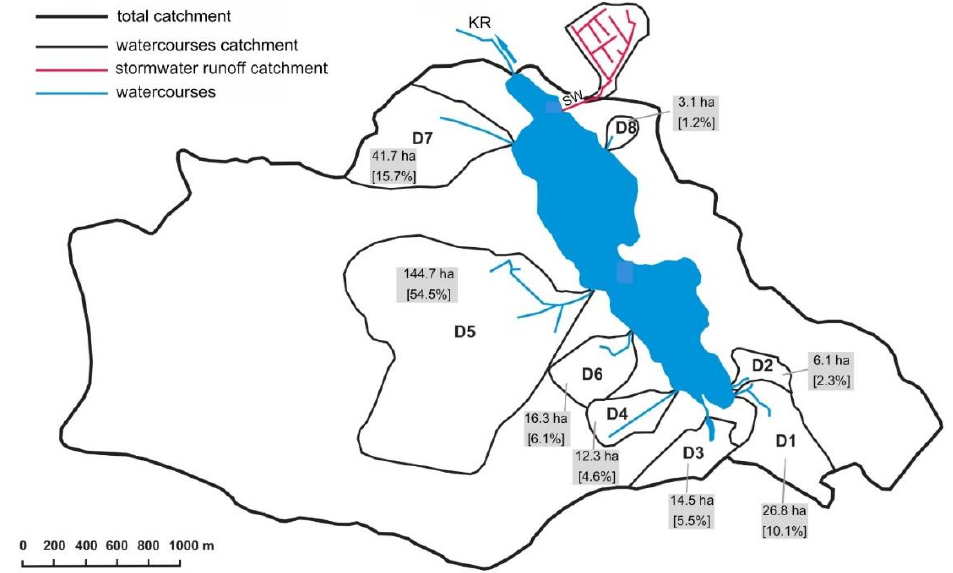
Figure 2. The total catchment area of Raczyńskie Lake and the partial catchments of its tributaries and stormwater (compiled on the basis of topographic map 1:10,000).